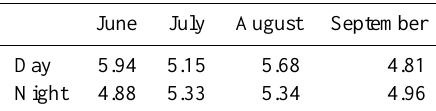
Table 2. Precipitation ice water path [gm − 2 ] in Tehuantepec re- gion during summer for day (06:00a.m.–06:00p.m.) and night